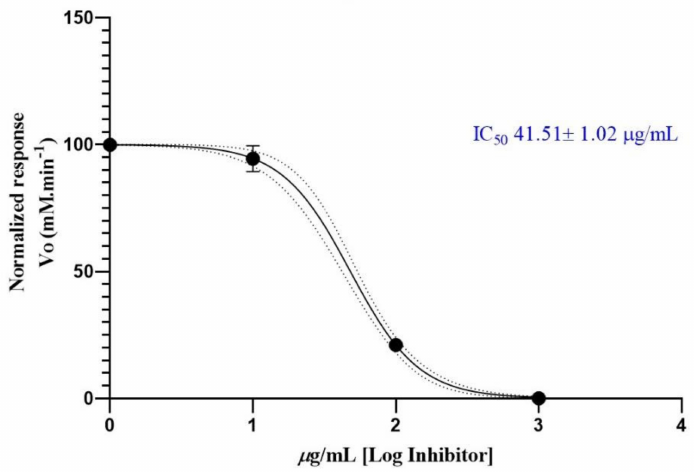
Figure 2. Half-maximum inhibitory concentration of Annona cherimola essential oil against acethyl-